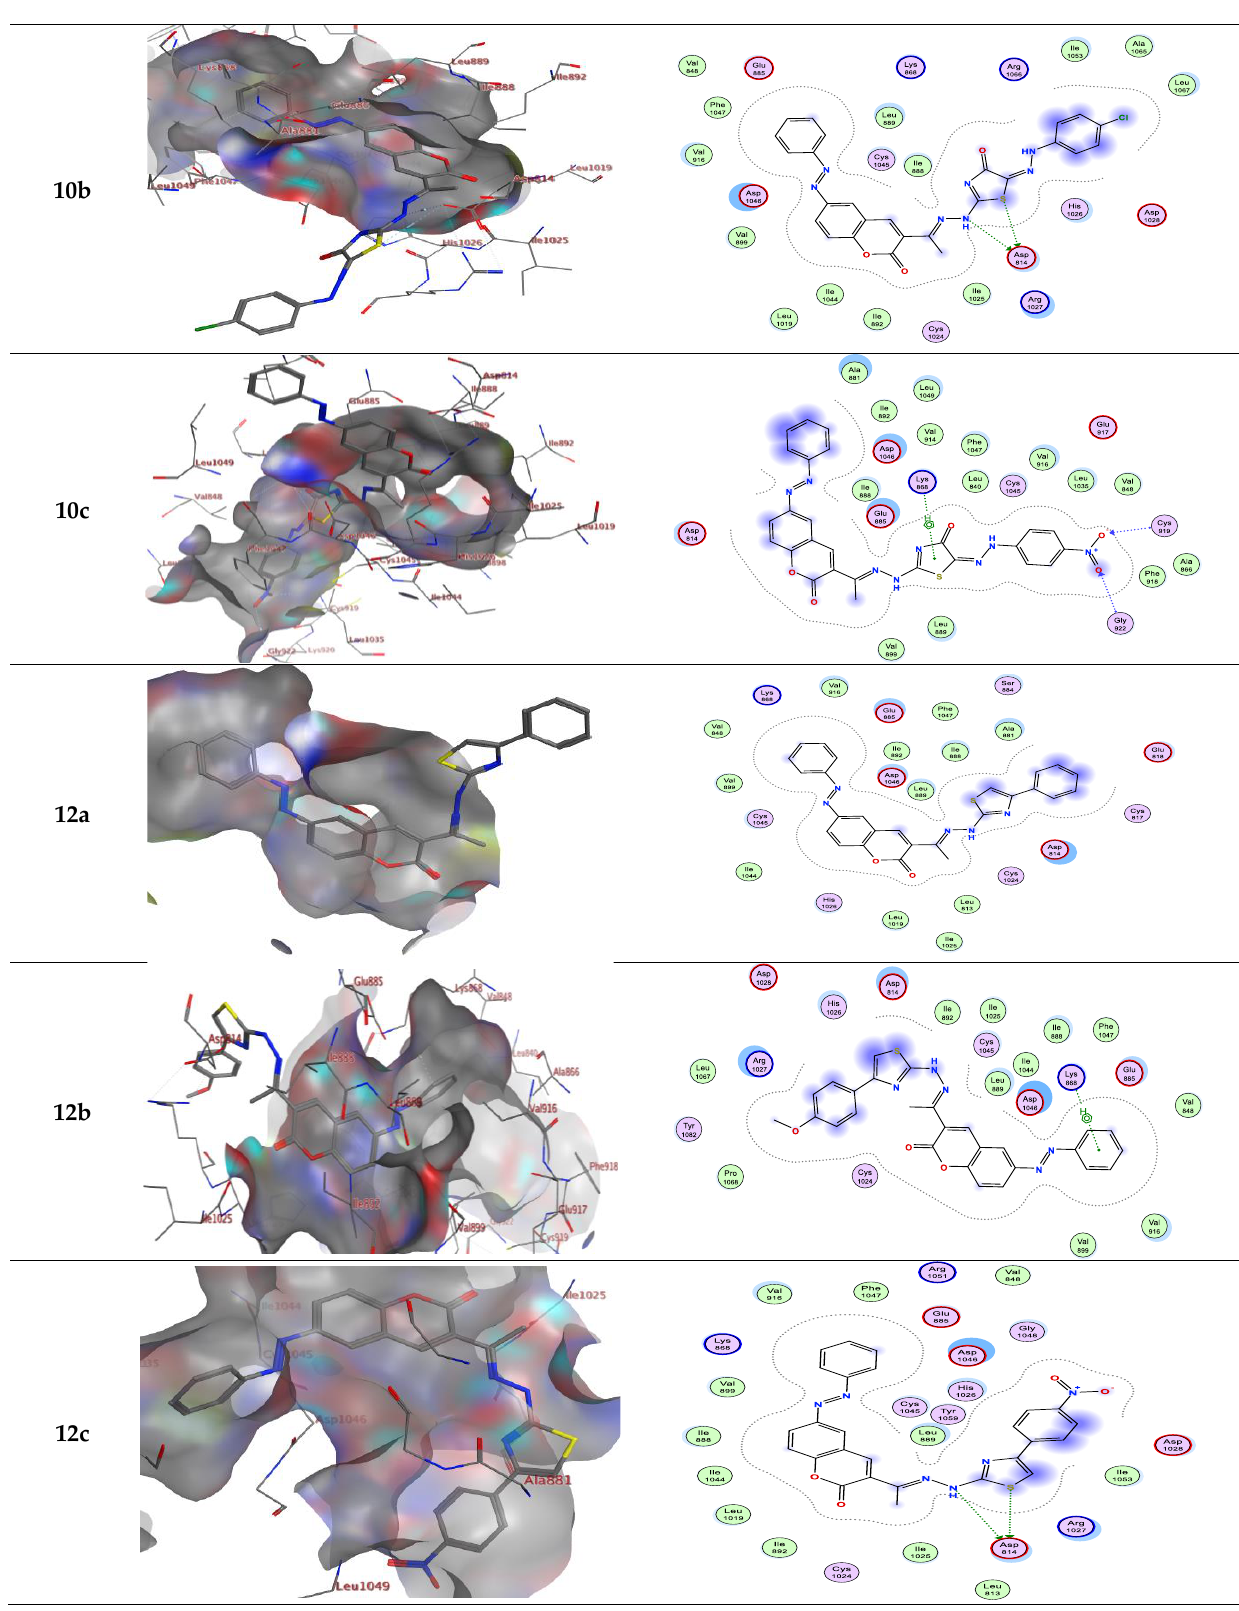
Figure 5. Interactions between ligands in three dimensions (left) and two dimensions (right) within a compound’s binding pocket of 4ASD (type I VEGFR-2 inhibitor) for compounds 3 , 6a–e , 10a–c and 12a–c